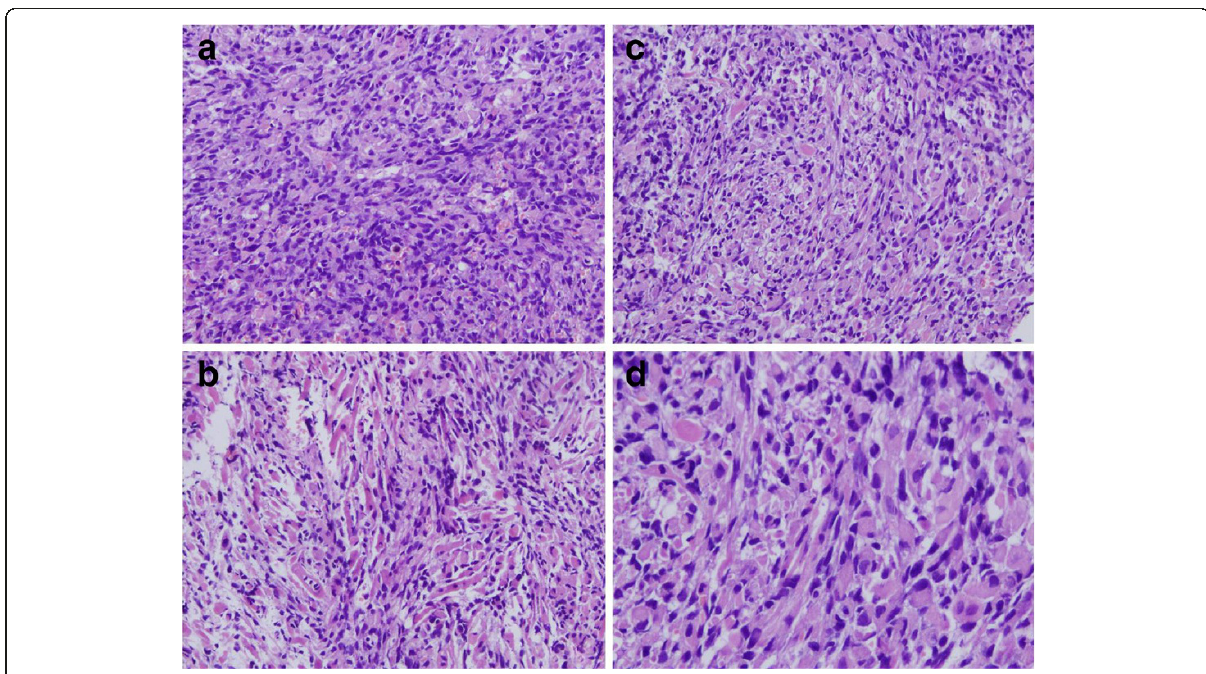
Figure 1 Microscopically, the tumor was composed of spindle cells with wavy nucleus and scattered or focal large cells which were rounded or elongated with abundant deep eosinophilic cytoplasm. Cross striations were found in few of them. Mitotic figures were scarce in the cellular areas. A, ×200; B, ×200; C, ×200; D,